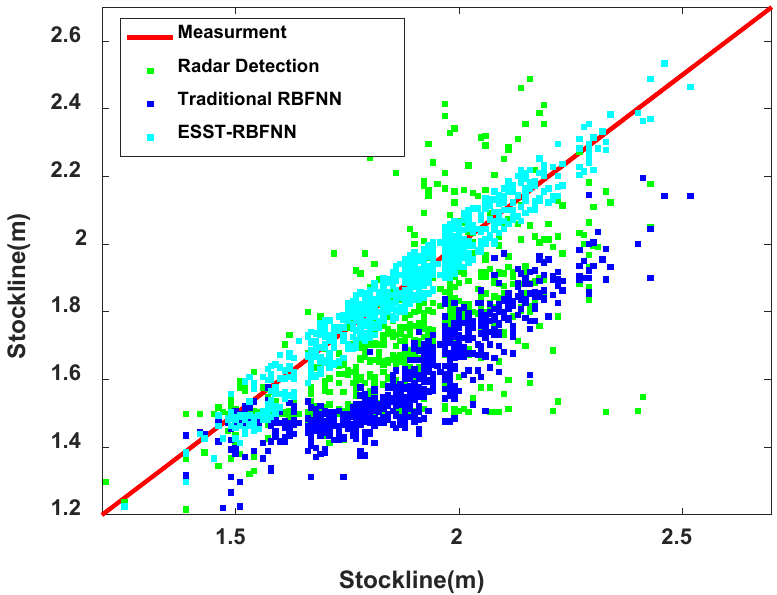
Figure 13. The 45 ◦ line diagram of the measurement effect of the three methods. To further verify the correctness and effectiveness of the proposed method, the 24-h operation data based on the 10,000 rows of validation data of the ESST-RBFNN method were collected to draw the operation effect diagram, as shown in Figure 14. The absolute error, relative error and hit rate of radar probe, and the methods of traditional RBFNN and ESST-RBFNN for up to 3 months are counted, as shown in Table 2. It can be seen from Figure 14 that based on the 10,000 rows of validation data within 24 h of operation, whether under normal or abnormal conditions, the detection method of ESST-RBFNN can well track the mechanical probe data with high accuracy and reliability. At the same time, it can well fit the periodicity and variation trend of the radar data and has good real-time continuity. From the 3-month statistical error analysis in Table 2, the MRE (Mean Relative Error) and RMSE (Root Mean Square Error) of the burden level detection method of ESST-RBFNN are nearly four times higher than those of the radar probe and the method of traditional RBFNN. The hit rate of samples with relative error lower than 2% reaches up to 91.17%. The hit rate of samples with relative error lower than 5% even reaches up to 99.33%. Compared with the radar probe and the method of traditional RBFNN, there is a significant qualitative improvement. The statistical analysis data further illustrate that the burden level detection method of ESST-RBFNN proposed in this paper can obtain continuous and accurate blast furnace burden level information with high precision.